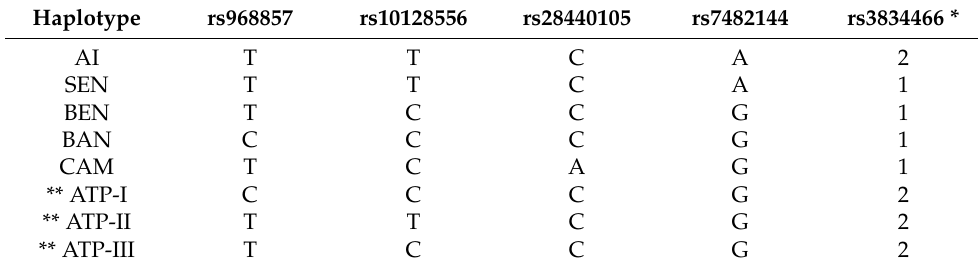
Table 1. Alleles of the 5 SNPs used to define the common haplotypes.